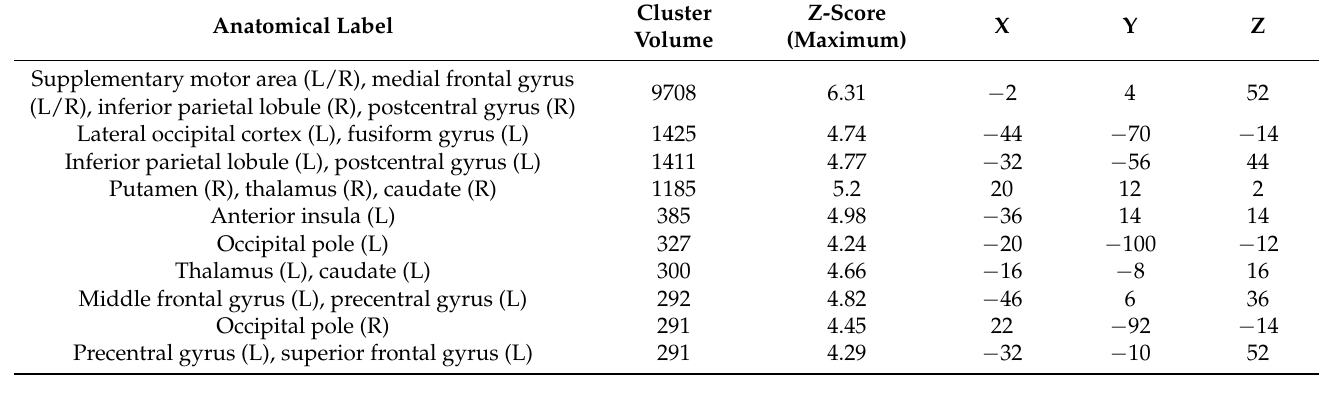
Table 3. Main effects—rested condition. The table lists the approximate anatomical details of the suprathreshold clusters. Z-score represents the maximum Z value within the given cluster. X, Y, and Z values denote MNI coordinates of the maximum Z-value voxel. Cluster volume is given as a voxel count. Anatomical labels were identified using the Harvard- Oxford Cortical and Subcortical Atlases, Juelich Histological Atlas, and Talairach Daemon Labels as provided by FSL software (https://fsl.fmrib.ox.ac.uk/fsl/fslwiki/Atlases (accessed on 20 August 2021)). The characters within parentheses accompanying the anatomical labels indicate the hemisphere—left or right.